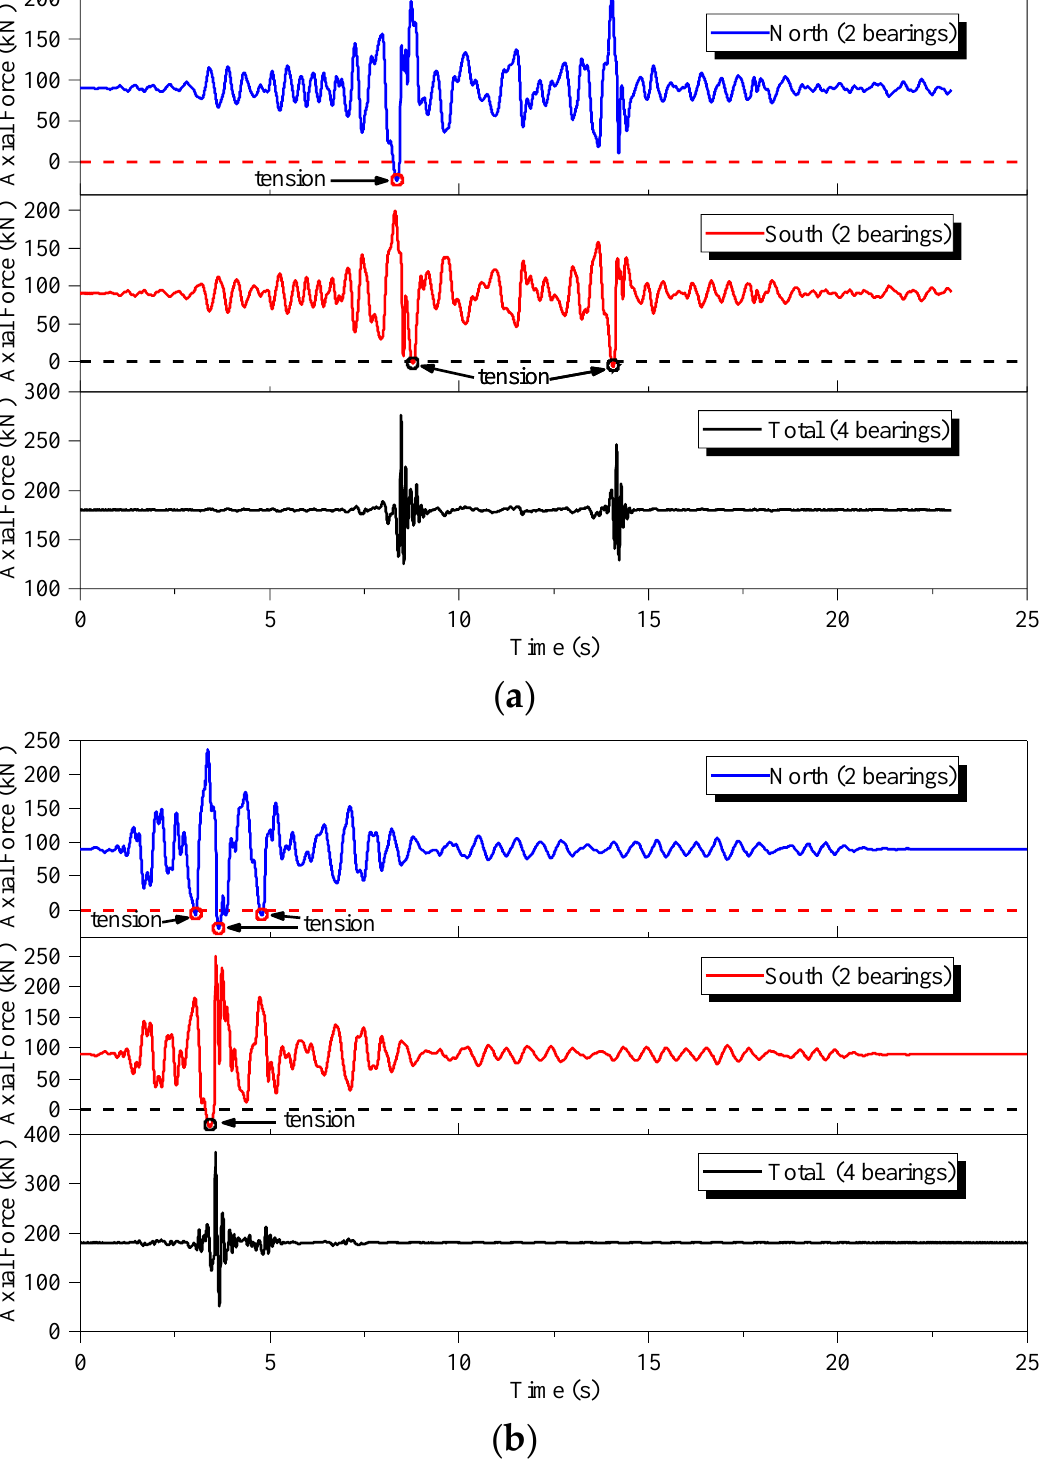
Figure 11. History of the record axial force of the LNRs subjected to: ( a ) ChiChi_NP_0.80 g; ( b ) Kobe_NP_0.80 g.